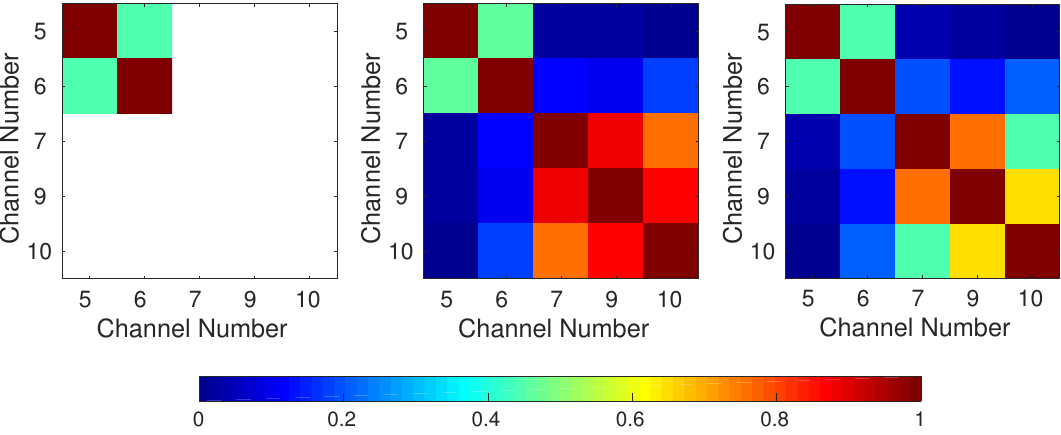
Figure 4. Estimated observation error correlation matrix for assimilated SEVIRI channels over land ( left ); coast ( center ); and sea ( right ). We remark that more than 50,000 samples were used to calculate the entries of each of the land, coast and sea inter-channel covariance